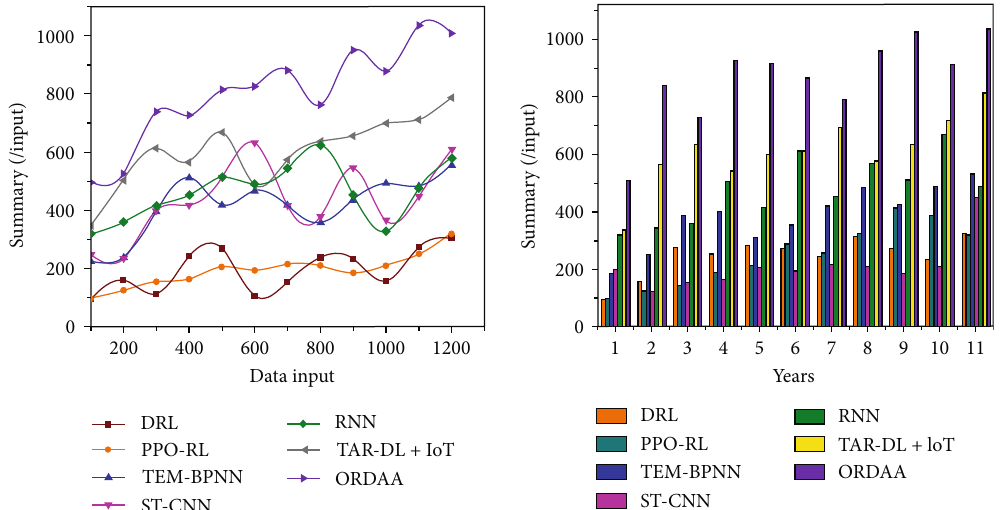
Figure 12: Data summary